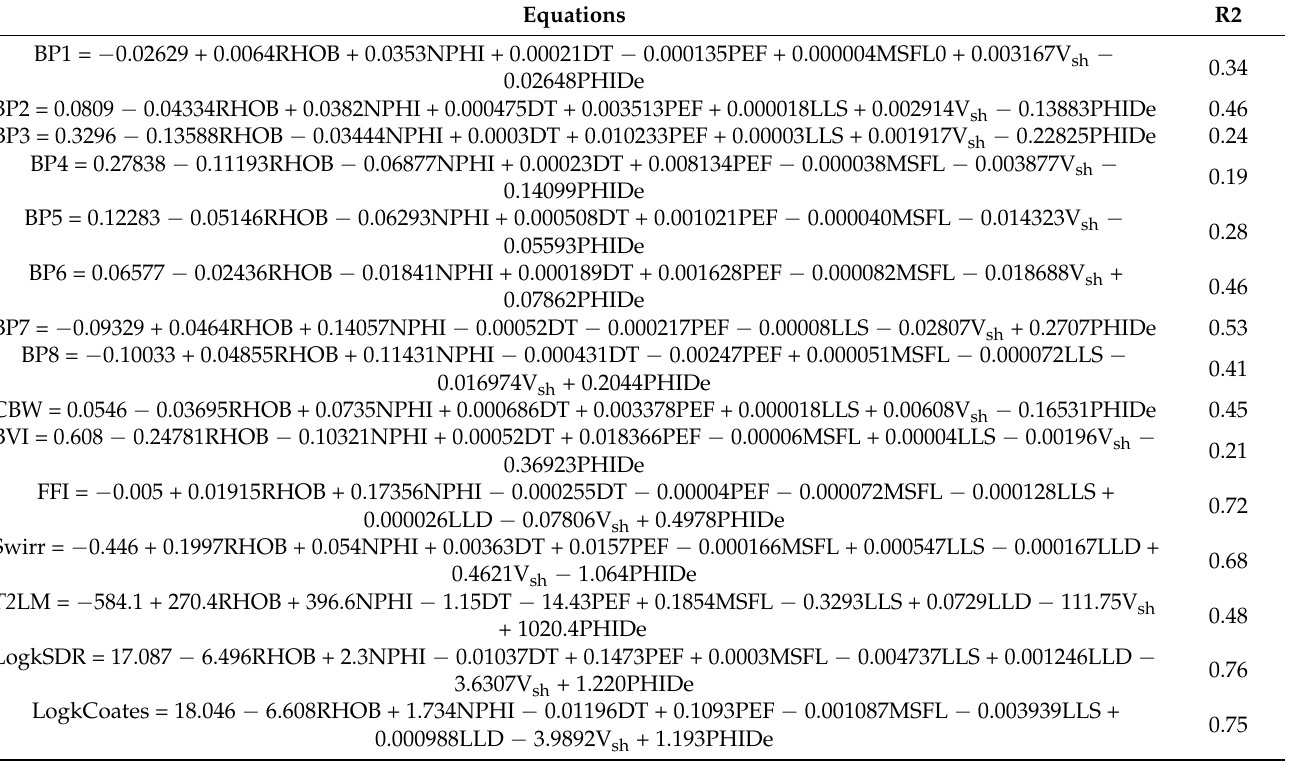
Table 3. MRA equations for the calculation of NMR log outputs. Variables with ignorable influence are removed from the equations.